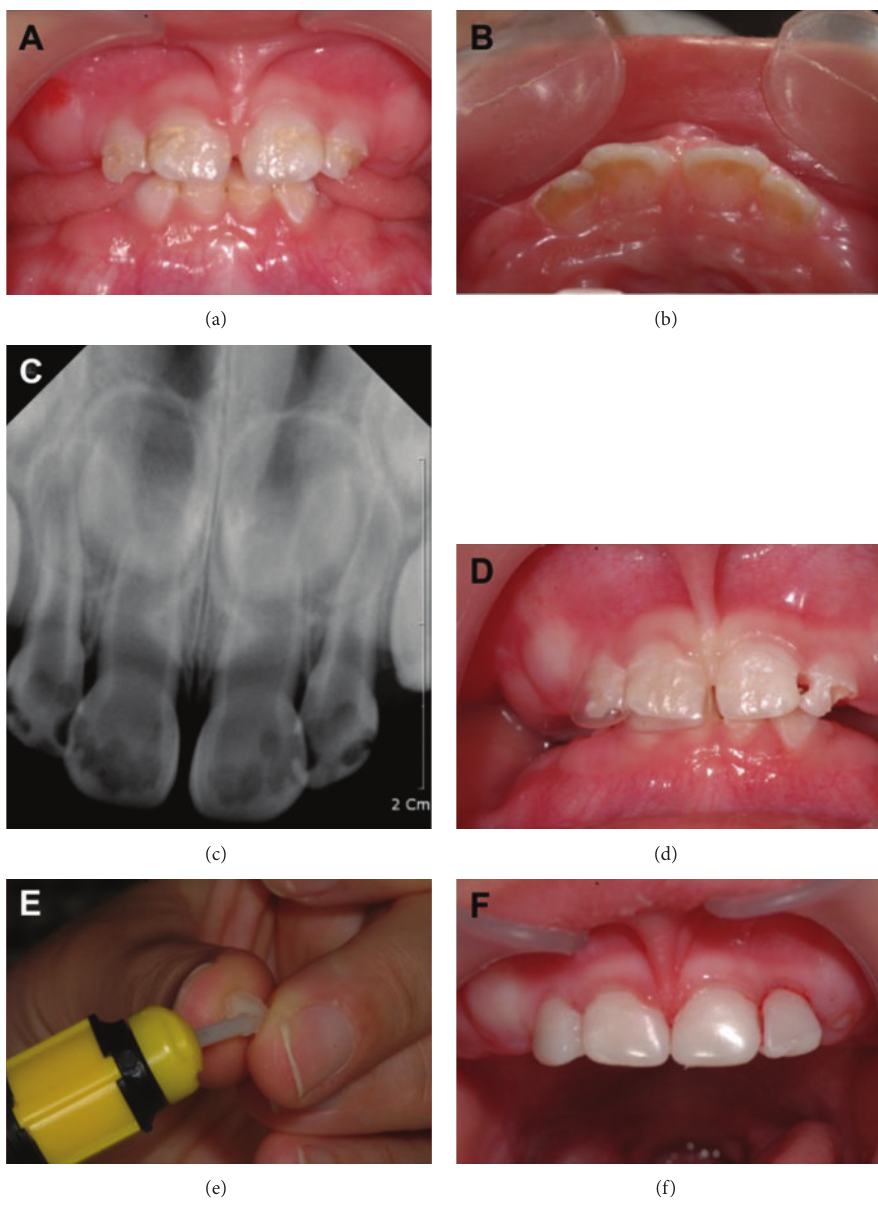
Figure 3: (a) Oral status of the patient before treatment (labial surface), (b) oral status of the patient before treatment (lingual surface), (c) radiograph of the patient before treatment, (d) mounting of strip crown on patient’s tooth, (e) filling strip crown with RelyX Unicem, and (f) restoration with RelyX